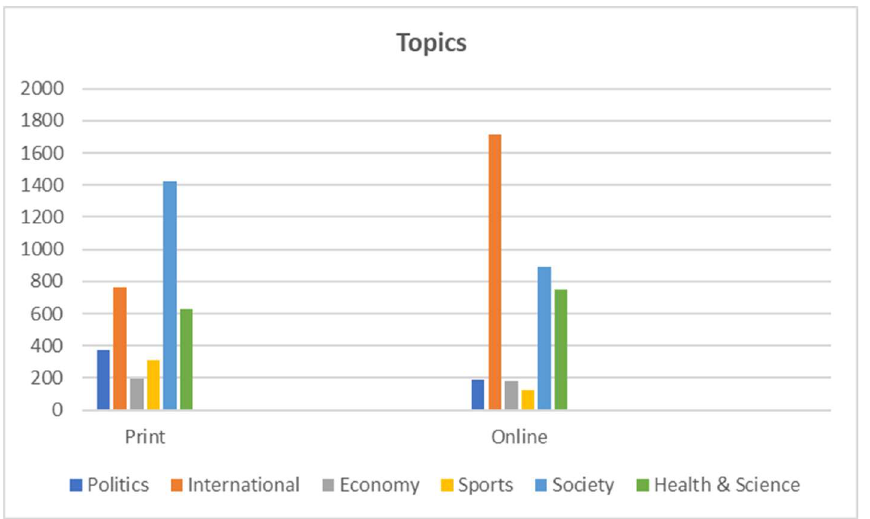
Figure 6. Topic categories.